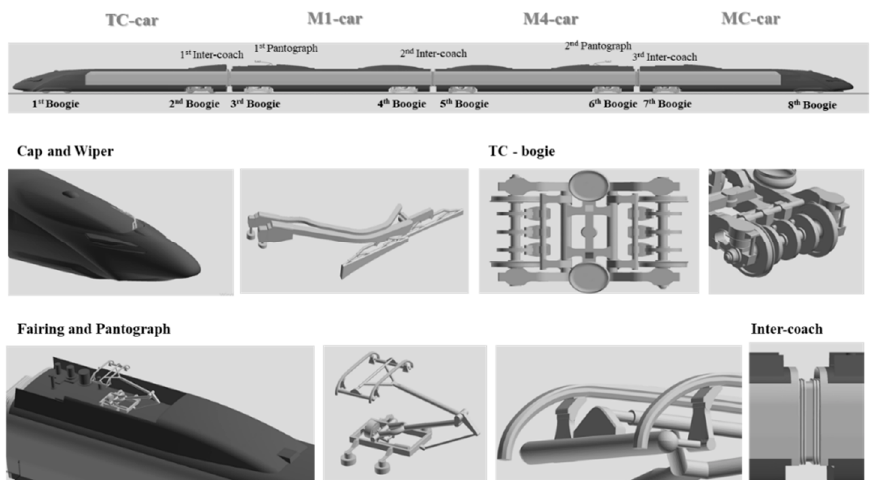
Appl. Sci. 2019 , 9 , 4924